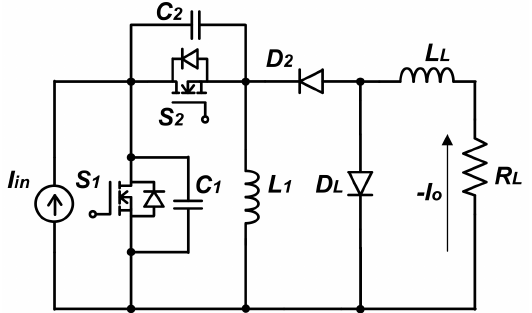
Figure 2. Inverting design of resonant switched-inductor converter